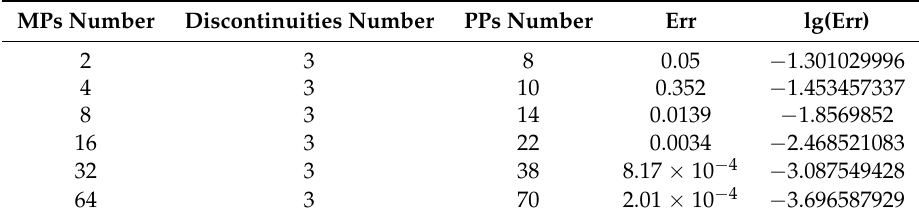
Table 1. The convergency of NMM with initial mathematical cover, the error is decreasing when the initial MPs is